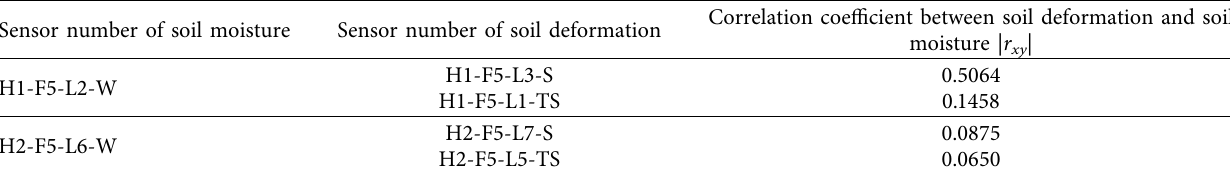
Table 6: Correlation coefficient of roadbed soil deformation and soil moisture.